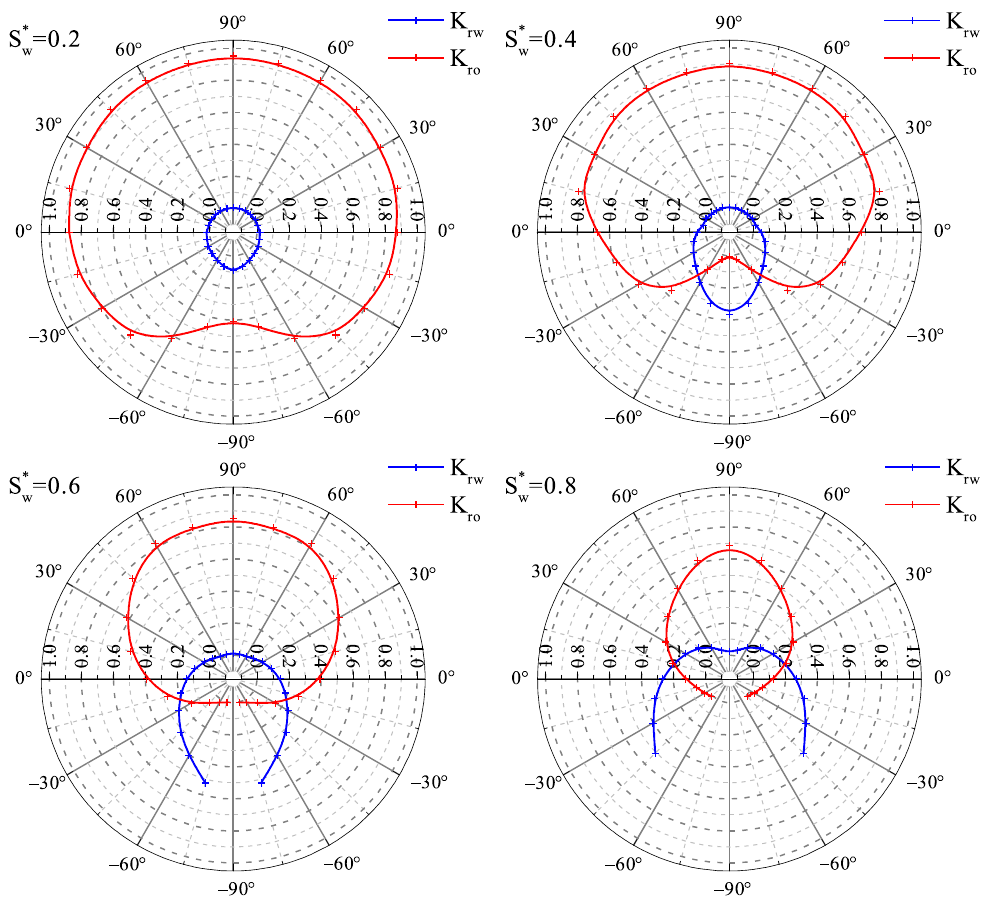
Figure 18. Upscaled relative permeability of the single-vug model at four different dimensionless water saturations in a polar coordinated system. Note that if the relative permeability is isotropic, then the points should be located on the same circle.